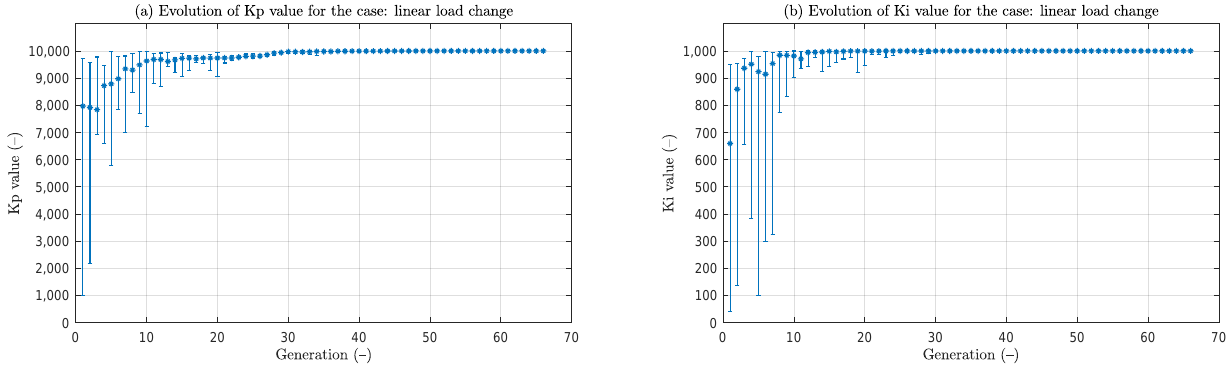
Figure 15. Evolution of parameters for the case of linear load change: ( a ) Kp; ( b )